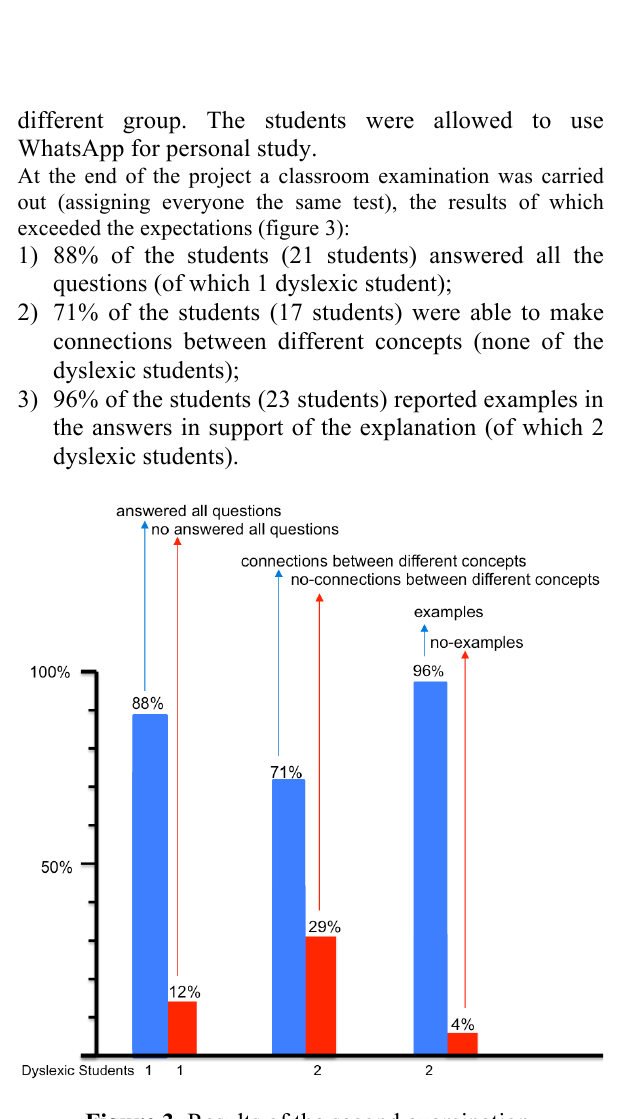
Figure 3. Results of the second